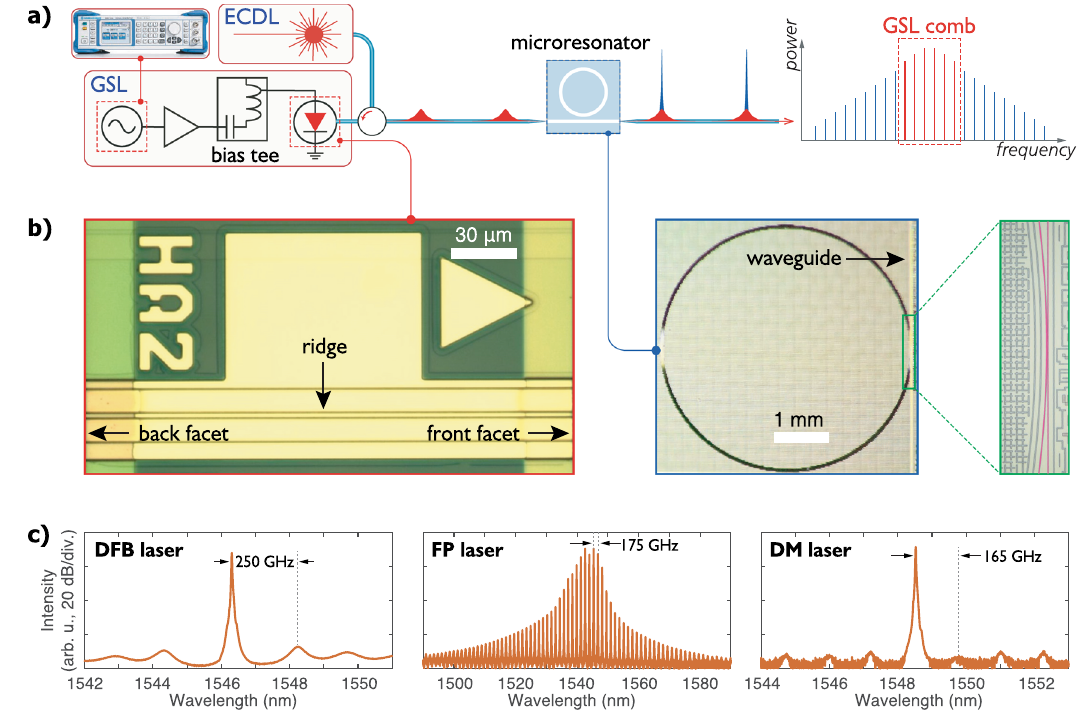
Fig. 1 Gain-switched semiconductor lasers for pulsed pumping of microcombs. a Pumping scheme for soliton generation. The bias current of an injection- locked semiconductor laser is modulated to produce a pulse train to generate DKSs in a microresonator. A microwave synthesiser (Rohde and Schwarz SMB100A) is providing the gain-switching frequency. b The photographs of (left) a Fabry – Perot laser chip (middle), a Si 3 N 4 microresonator and (right) the enlarged coupling area (the microring and the waveguide are in pink for visibility). c The CW lasing spectra (i.e., without optical injection, gain switching deactivated) of the three semiconductor lasers used in this study, including (left) a distributed feedback laser, (middle) a Fabry – Perot laser and (right) a discrete mode